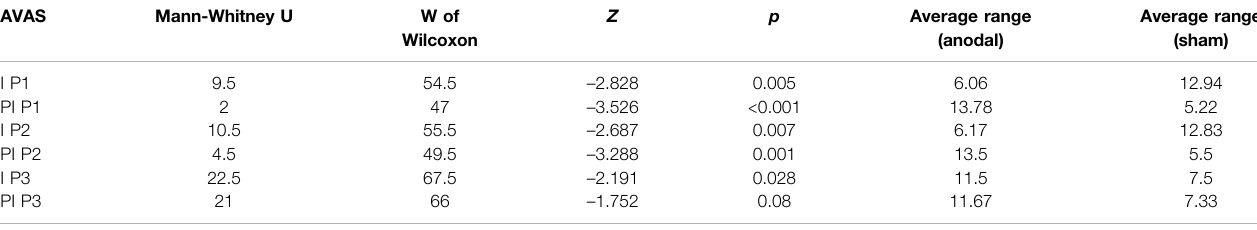
TABLE 1 | Results of the Wilcoxon-Mann-Whitney Test conducted to compare the AVAS mean values of pain intensity and improvement obtained in the anodal and sham stimulation conditions in each patient. AVAS